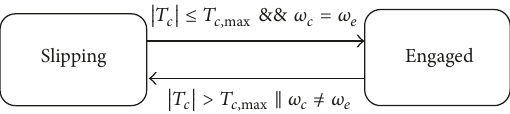
Figure 3: Switching logic of the clutch